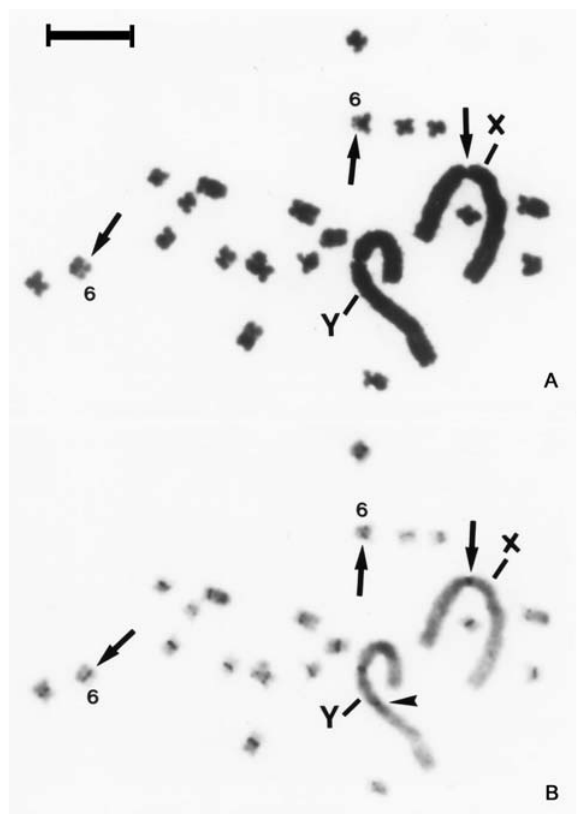
Figure 3 - Male Paranaita opima embryo mitotic metaphase with 2n = 22 (20+XY). A. Standard Giemsa staining. B. The same cell as shown in A submitted to Giemsa staining followed by C-banding and showing centro- meric constitutive heterochromatin blocks on all chromosomes. Arrows indicate the centromeric region of some chromosomes. The arrowhead points to one of the interstitial C-bands on the sex chromosome. Bar = 10 (cid:2)